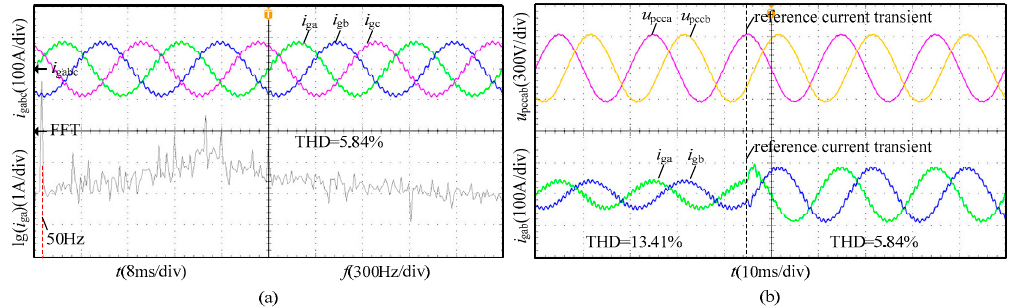
Figure 19. Experimental waveforms of u pcc and i g with proposed admittance reshaping technique 2 without the parameter design range. ( a ) Steady state; ( b ) Transient.